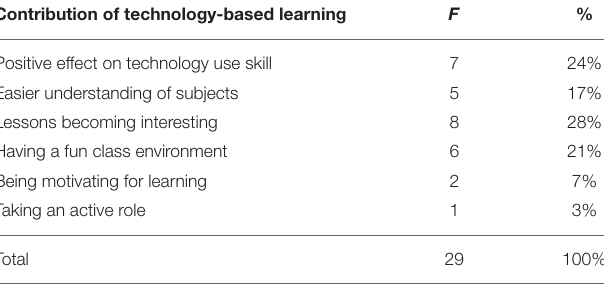
TABLE 2 | Student views on the benefit use of technology-based learning for students.